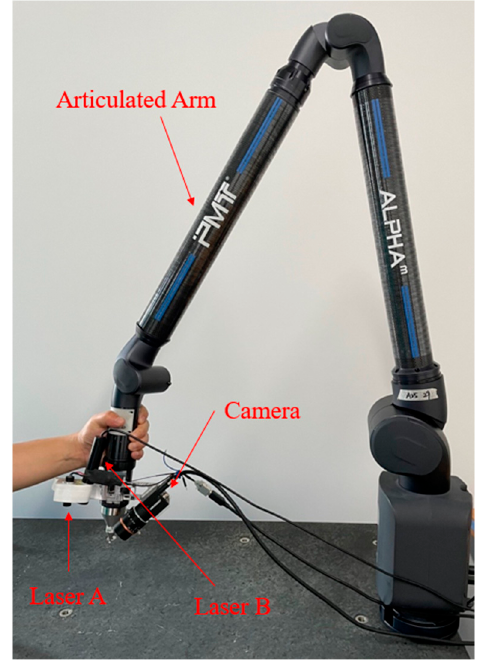
Figure 6. Hardware system.